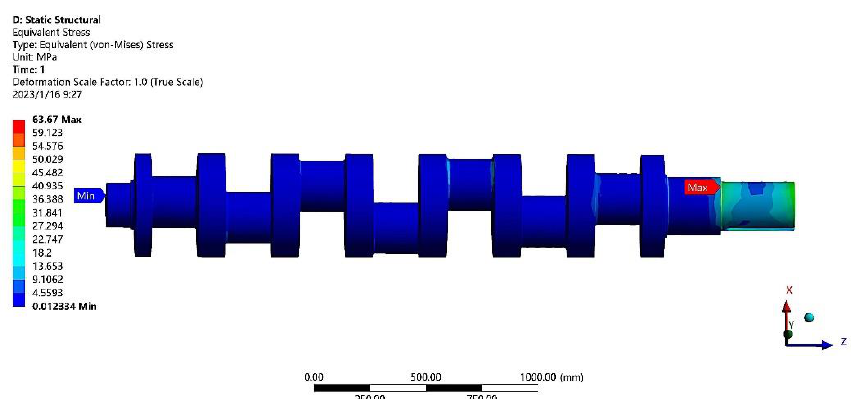
Figure 23. Diagram of the maximum equivalent stress under mesh refinement.